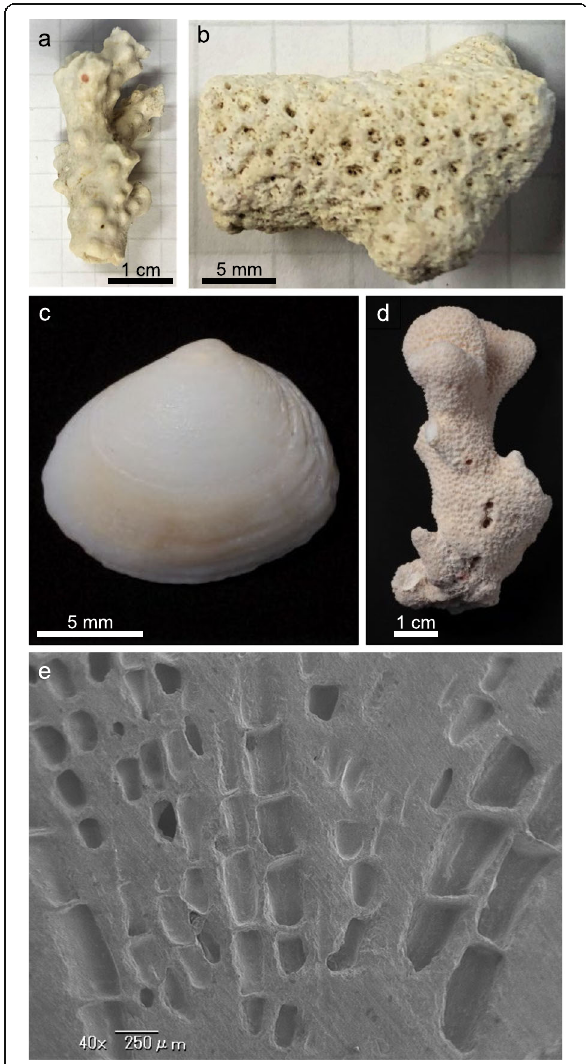
Fig. 8 Samples for radiocarbon dating: a Acropora sp. from L4; b Acropora sp. from L4; c Atactodea striata from L2; d Palauastrea ramosa from L2; e SEM image of P. ramosa from L2. These samples are composed exclusively of aragonite. Their external morphologies exhibit a good state of